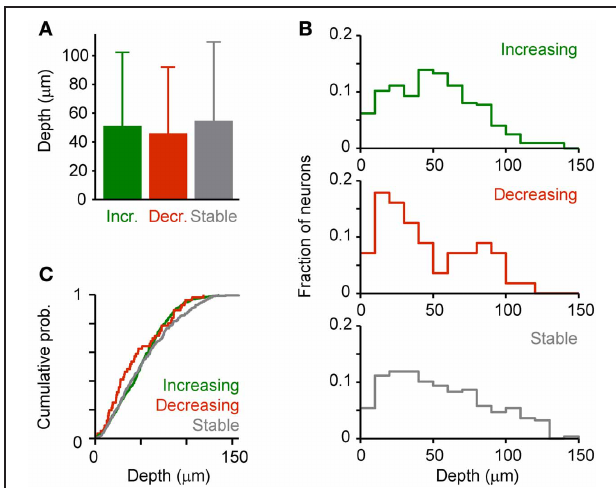
FIGURE 10 | Depth-dependence of DA effects. Dp neurons were assigned to one of three categories (“Increasing,” “Decreasing,” “Stable”) based on the effect of DA on the response evoked by an amino acid odor (His, 10 µ M; see text). (A) Mean depth of neurons in each category. (B) Depth distribution of each category. (C) Cumulative probability distributions. No statistically significant differences were detected between means or